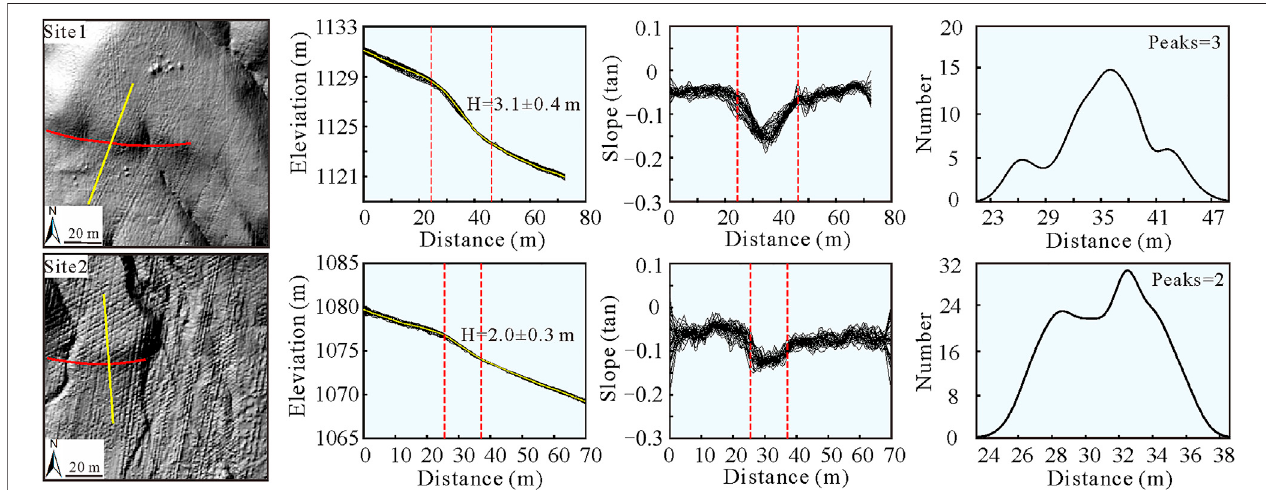
FIGURE 10 | Identi fi cation of slope breaks in the scarp pro fi les at two sites on the Xishanzui-Gongmiaozi segment. The fi rst column displays the LiDAR-DEM at each site, and the red and yellow lines represent the fault trace and extracted topographic pro fi le, respectively. In the second column, the black lines indicate the extractedswath topographicpro fi les (40 topographicpro fi les at aninterval of 0.5 m), and the yellow line denotes theaveraged topographicpro fi le,whilethered dashed linesmarkthescarprange.Inthethirdcolumn,theblacklinesindicatethecalculatedswathslopepro fi les.Inthefourthcolumn,theblacklinedenotestheprobability density distribution of the positions of all searched slope breaks in the swath slope pro fi les, and the number of peaks represent the number of slope breaks, that is the number of surface-rupturing events.